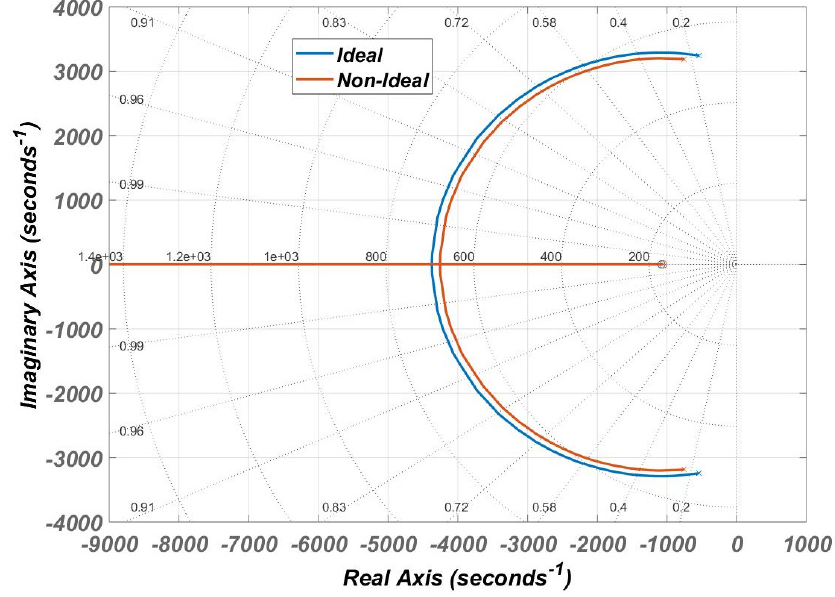
Figure 10. Bode plot of G id for ideal and non-ideal synchronous buck converters for R c = R L = 0.